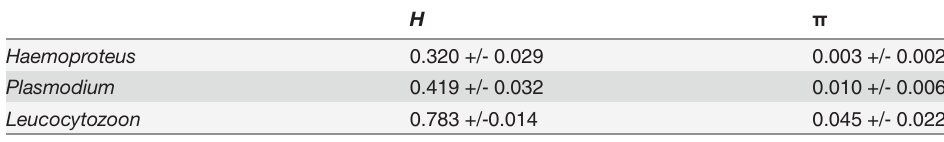
Table 3. Haplotype and nucleotide diversity values (H and π respectively) and their 95% con fi dence intervals for all haplotypes belonging to each genus of haemosporidian identi fi ed in this